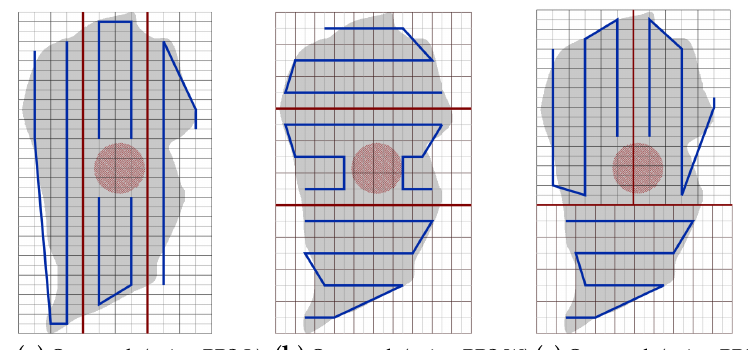
Figure 29. NFZ is located at the middle part of the grid.